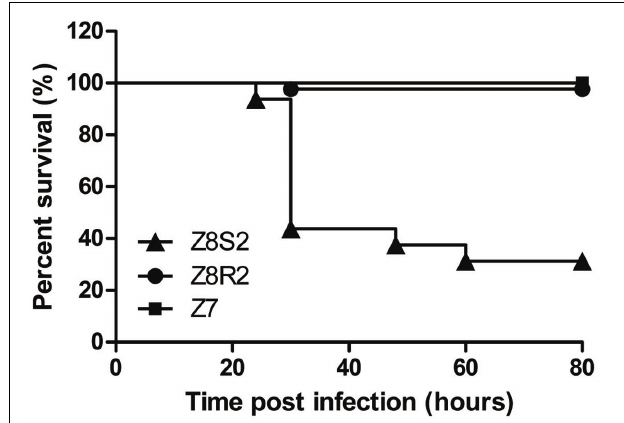
FIGURE 1 | Survival curves of flocks Z8S2 and Z8R2 after inoculated with virulent strain of DHAV-3. Flock Z8S2 and Z8R2 ducklings were infected intramuscularly with 10 5 . 7 ELD 50 of DHAV-3 112803 strain. Flock Z7 ducklings were infected intramuscularly with 0.2 ml of sterile phosphate-buffered saline (PBS). Mortality occurred between 24 and 60 h after infection in Z8S2 flocks and at 30 hpi in Z8R2 flocks.